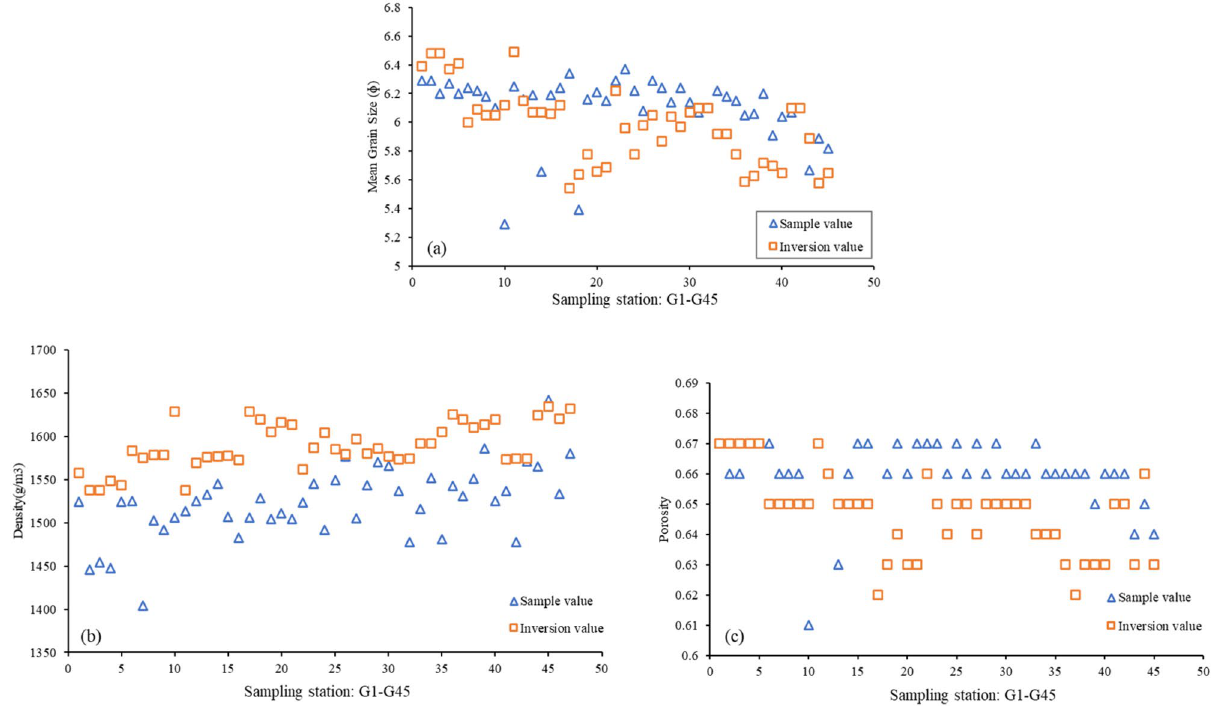
Figure 7. Comparison of inversion results and sample test results at sampling stations (G1–G45): ( a ) Comparison of mean grain size; ( b ) comparison of density; ( c ) comparison of porosity.